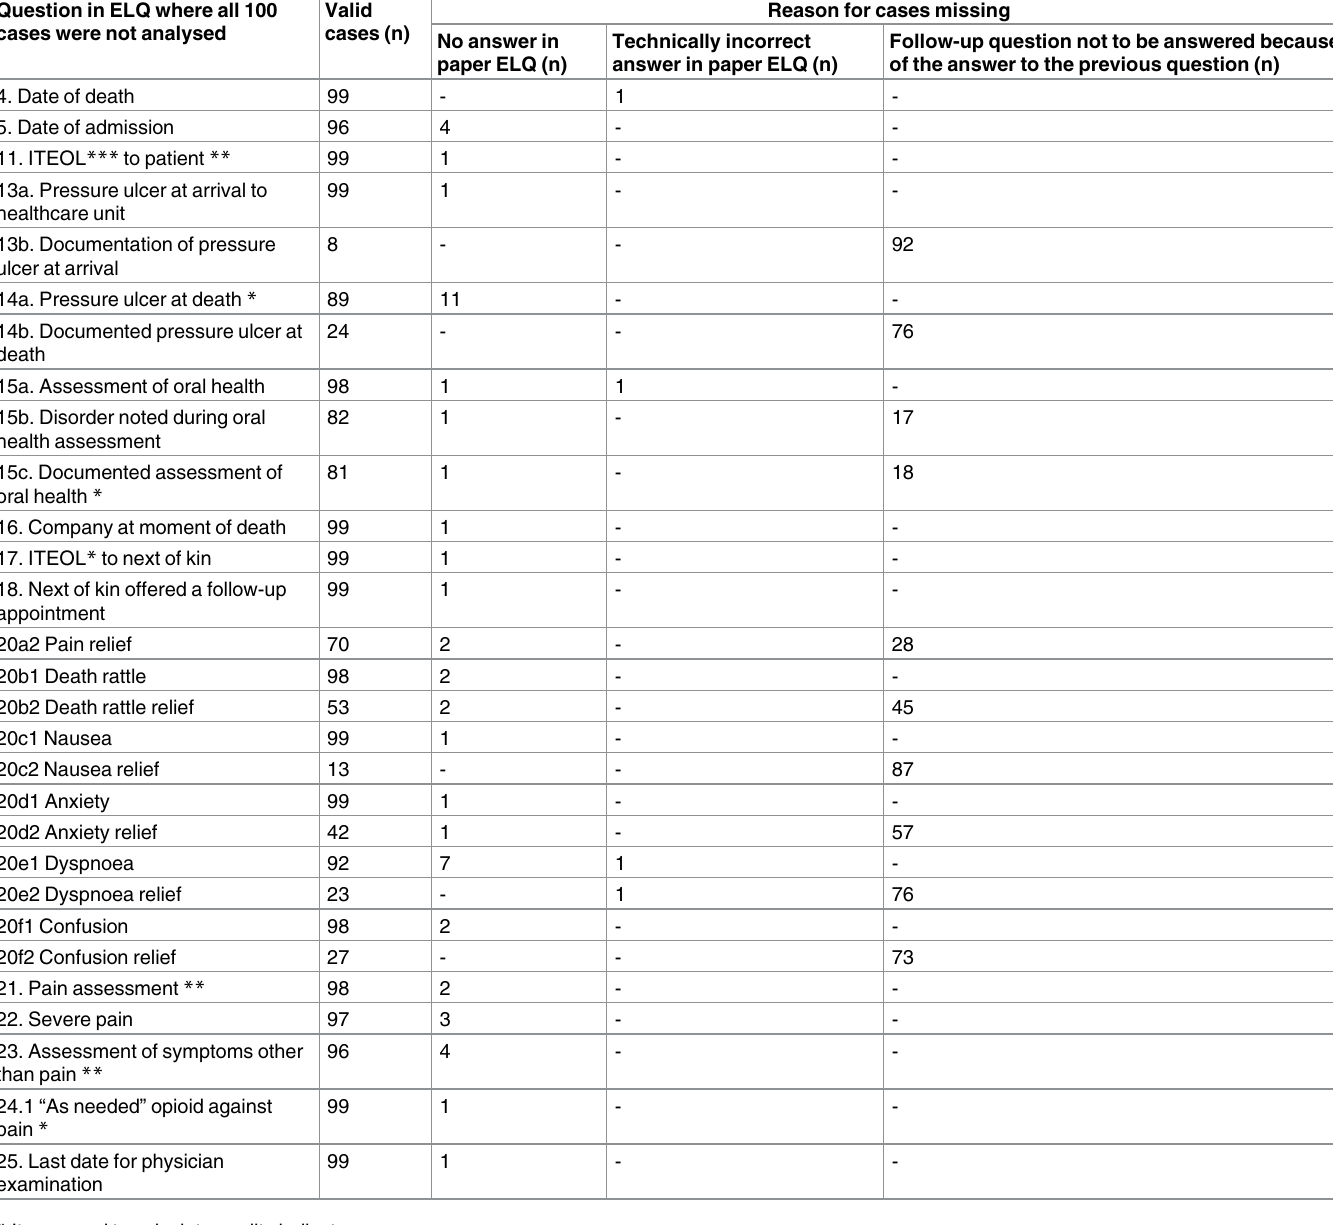
Table 4. Number of included and excluded cases for the ELQ items that did not include all 100 cases in the comparison between ELQ registrations in the SRPC and paper forms. Question in ELQ where all 100 cases were not